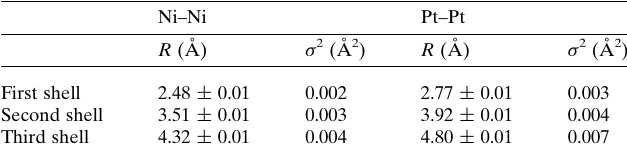
Table 2 EXAFS radial distances of Ni and Pt. Here R is the radial distance and (cid:7) 2 is the Debye–Waller factor.